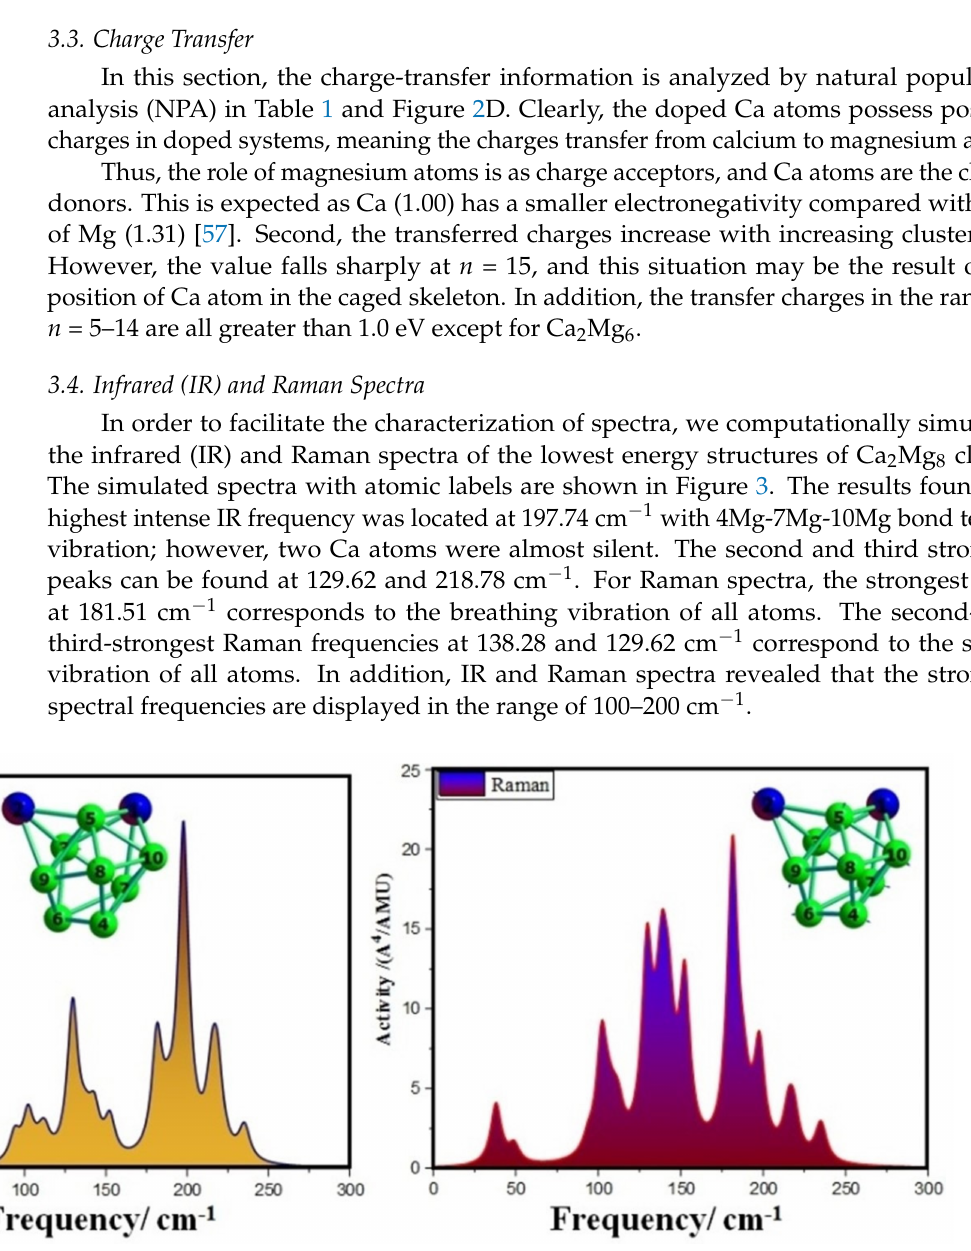
Figure 3. The Infrared and Raman spectra of the most stable cluster of the Ca 2 Mg 8